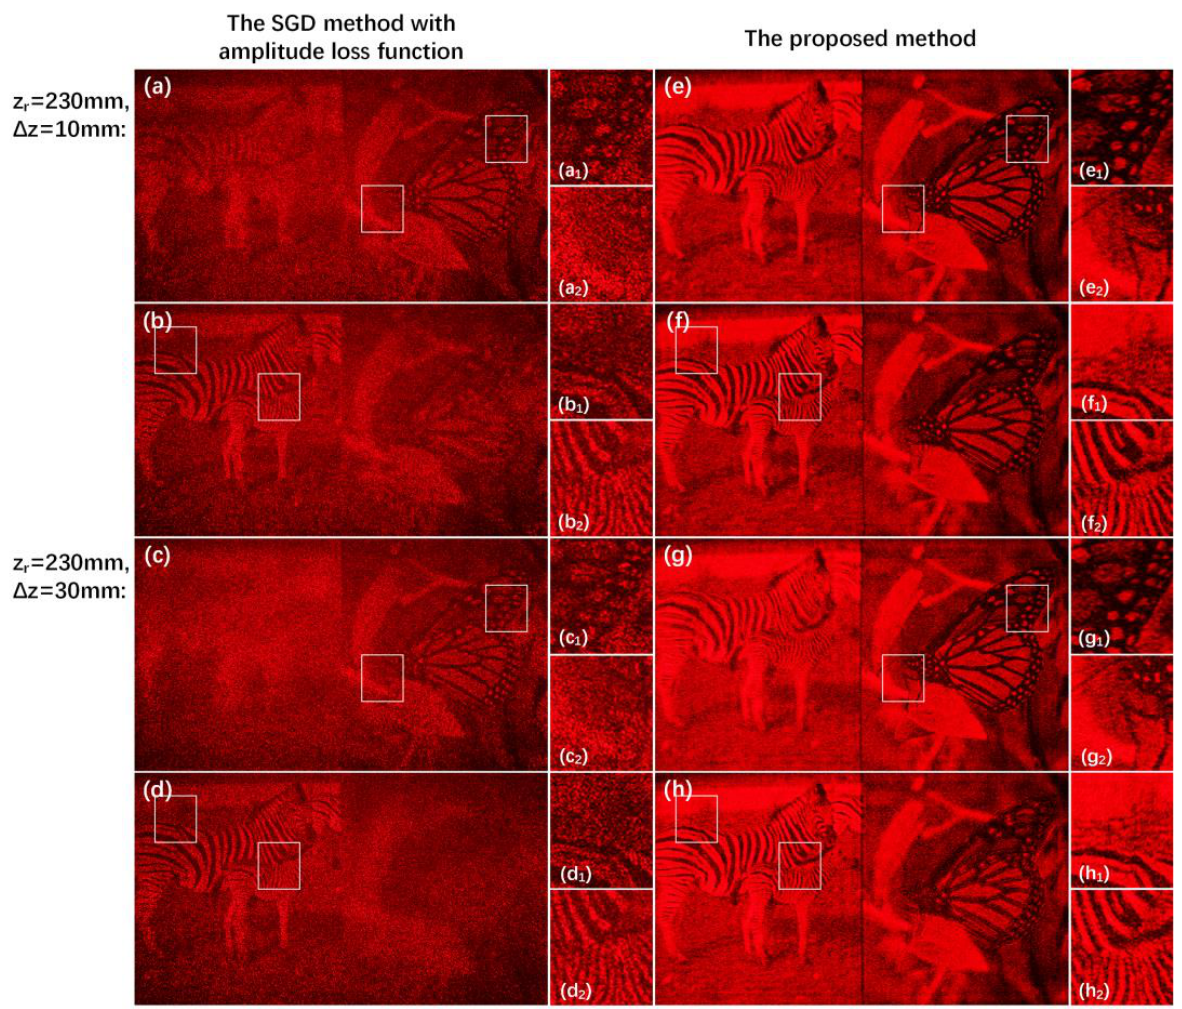
Figure 11. ( a – d ) are the optical reconstructed results of the SGD method with amplitude loss function and ( e – h ) are the optical reconstructed results of the proposed method when the distance z r is 230 mm and ∆ z is 10 mm and 30 mm, respectively. ( a 1 – h 1 ) and ( a 2 – h 2 ) are the details of ( a – h ) in the white box, respectively.